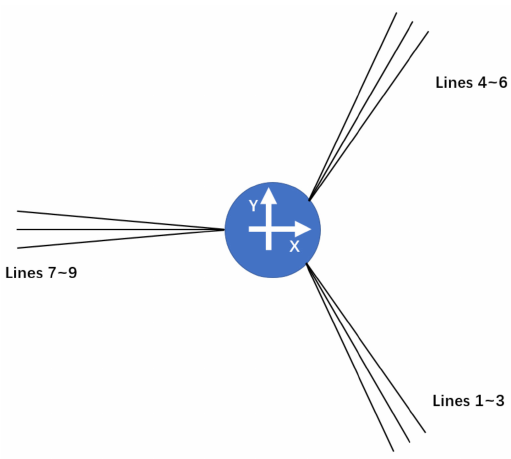
Figure 9. Configuration of the mooring